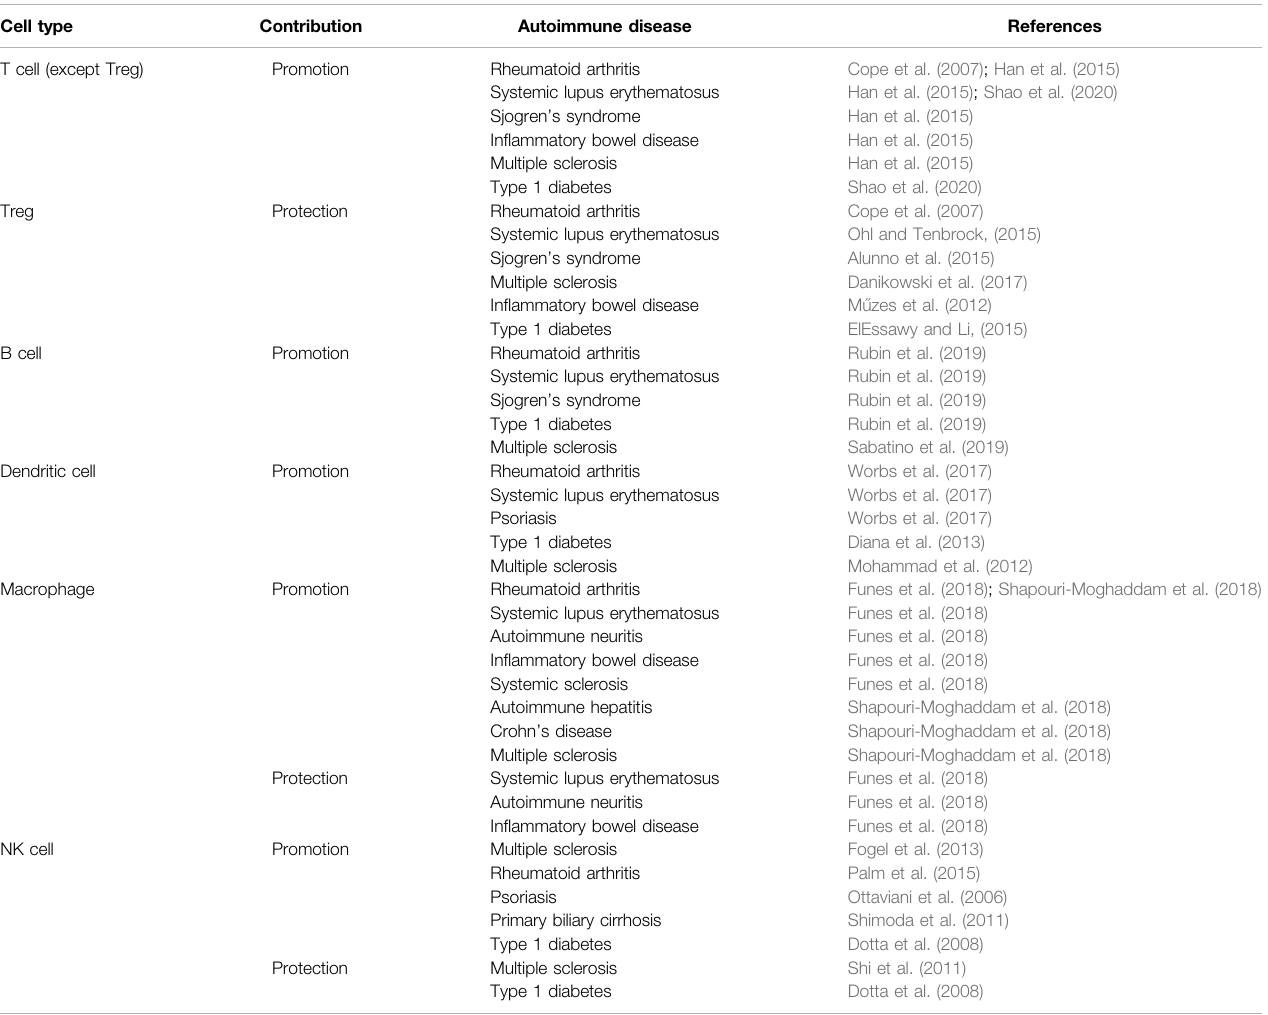
TABLE 2 | Contribution of immune cells to the development of autoimmune